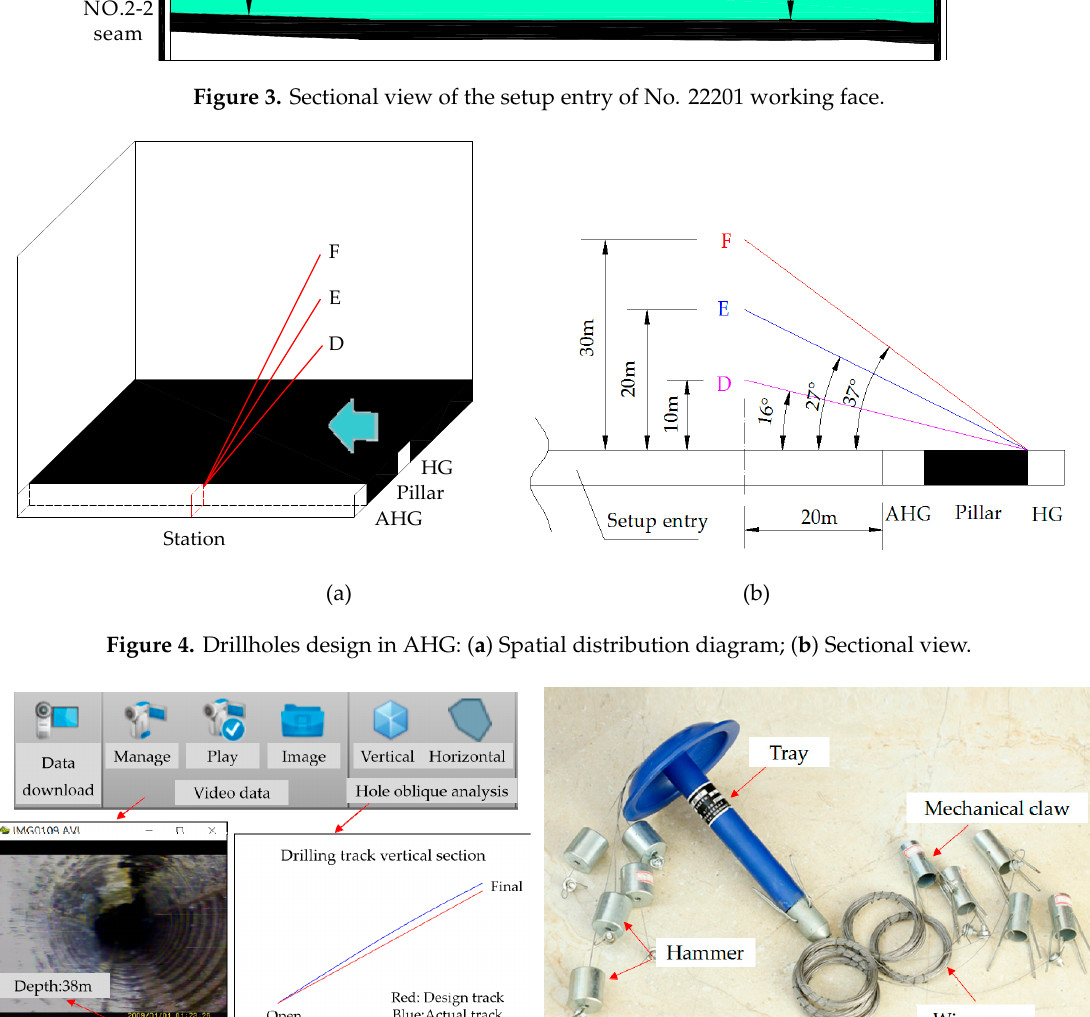
Figure 3. Sectional view of the setup entry of No. 22201 working face.